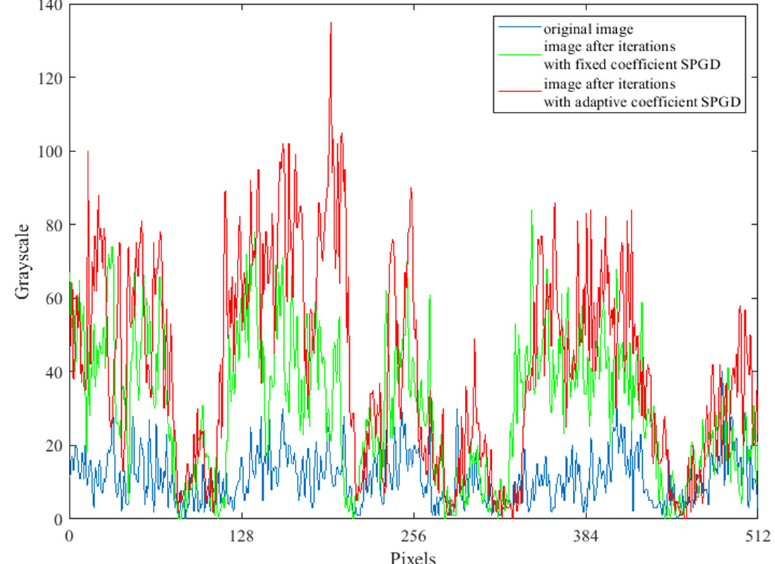
Figure 12. Grayscale graphs at the yellow line of the original image and two images after aberration correction.